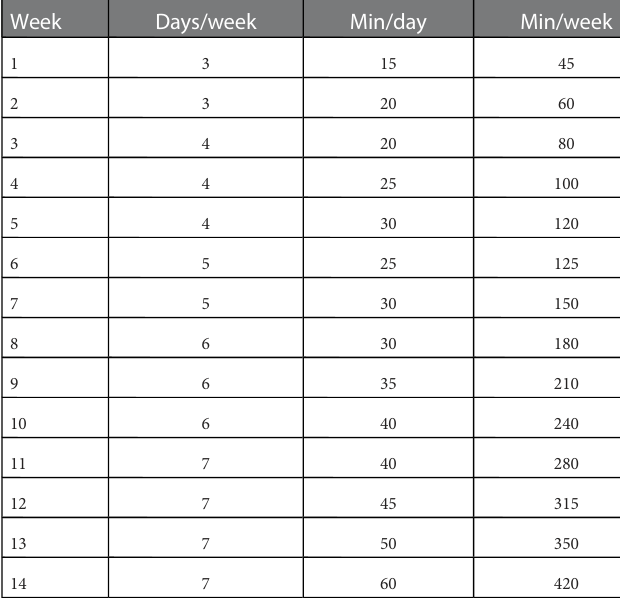
TABLE 3 Example of an exercise progression plan for youth with Down syndrome 6 – 17 years of age.